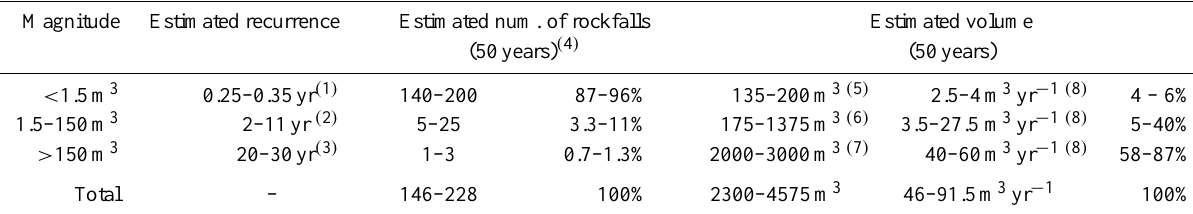
Table 4. Combination of short and long-term approaches: TLS monitoring campaign, historical record and population surveys. This table attempts to quantify the recurrence and volume of the rockfalls in the last 50years. The calculation of a “probability of occurrence” is beyond the scope of this research.